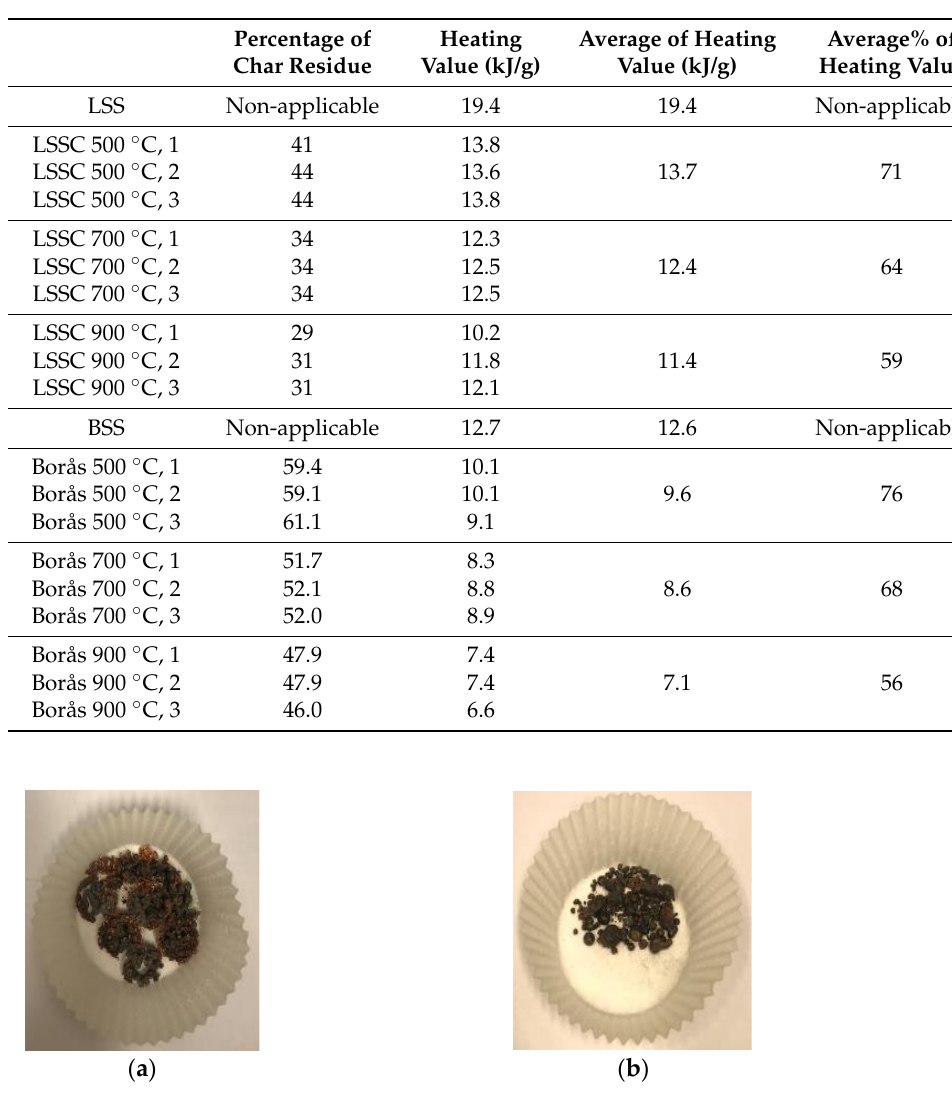
Figure 6 . Appearance of the ash fractions collected from combustion in the bomb calorimeter: ( a ) Lidköping sludge ashes and ( b ) Borås sludge ash. Table 4. The content of the main elements in the municipal sewage sludge (MSS) and sewage